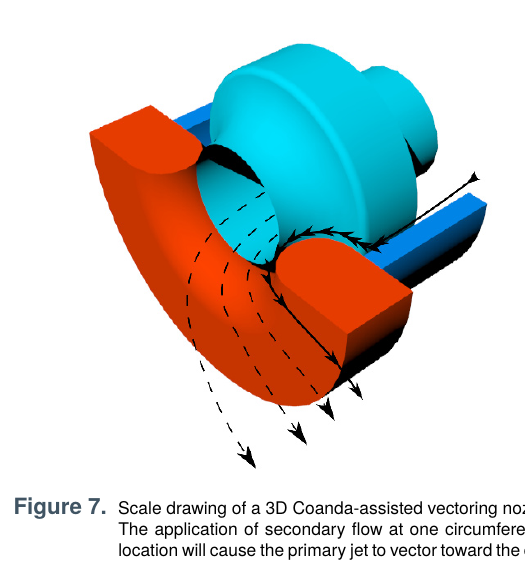
Figure 7. Scale drawing of a 3D Coanda-assisted vectoring nozzle. The application of secondary flow at one circumferential locationwillcausetheprimaryjettovectortowardthecon- trol